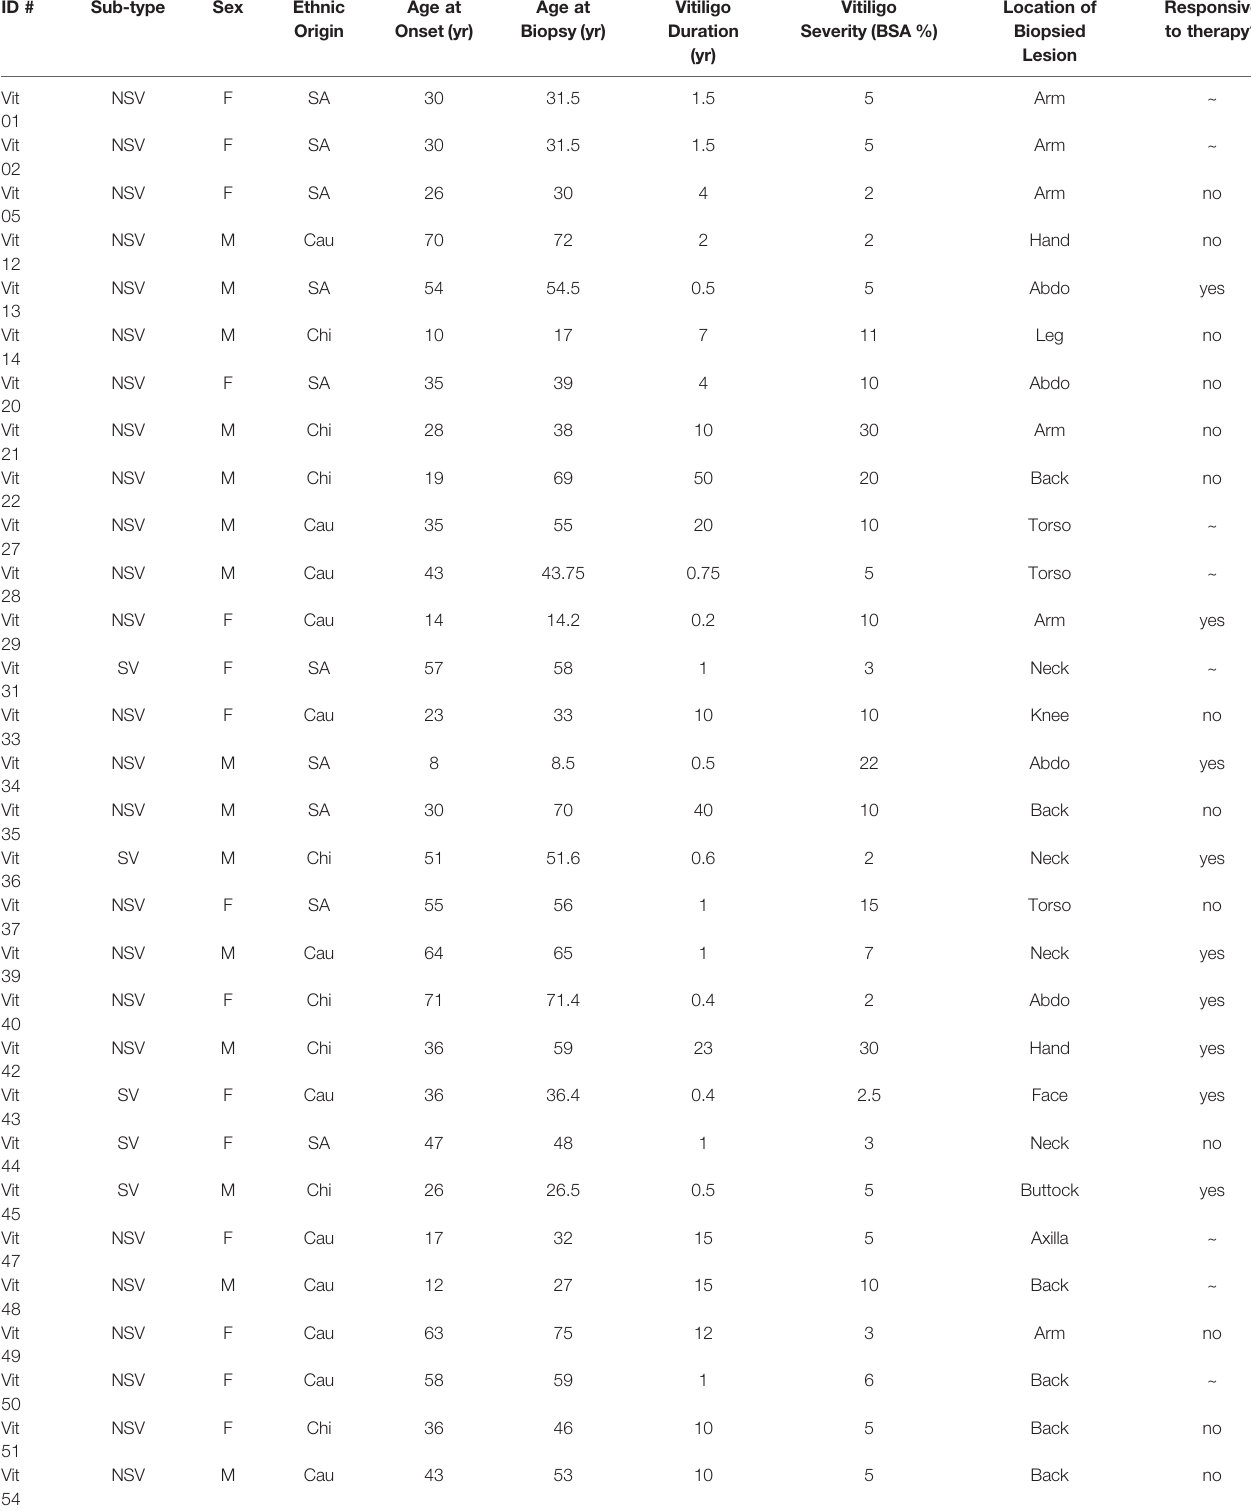
TABLE 1 | Clinical Information of vitiligo